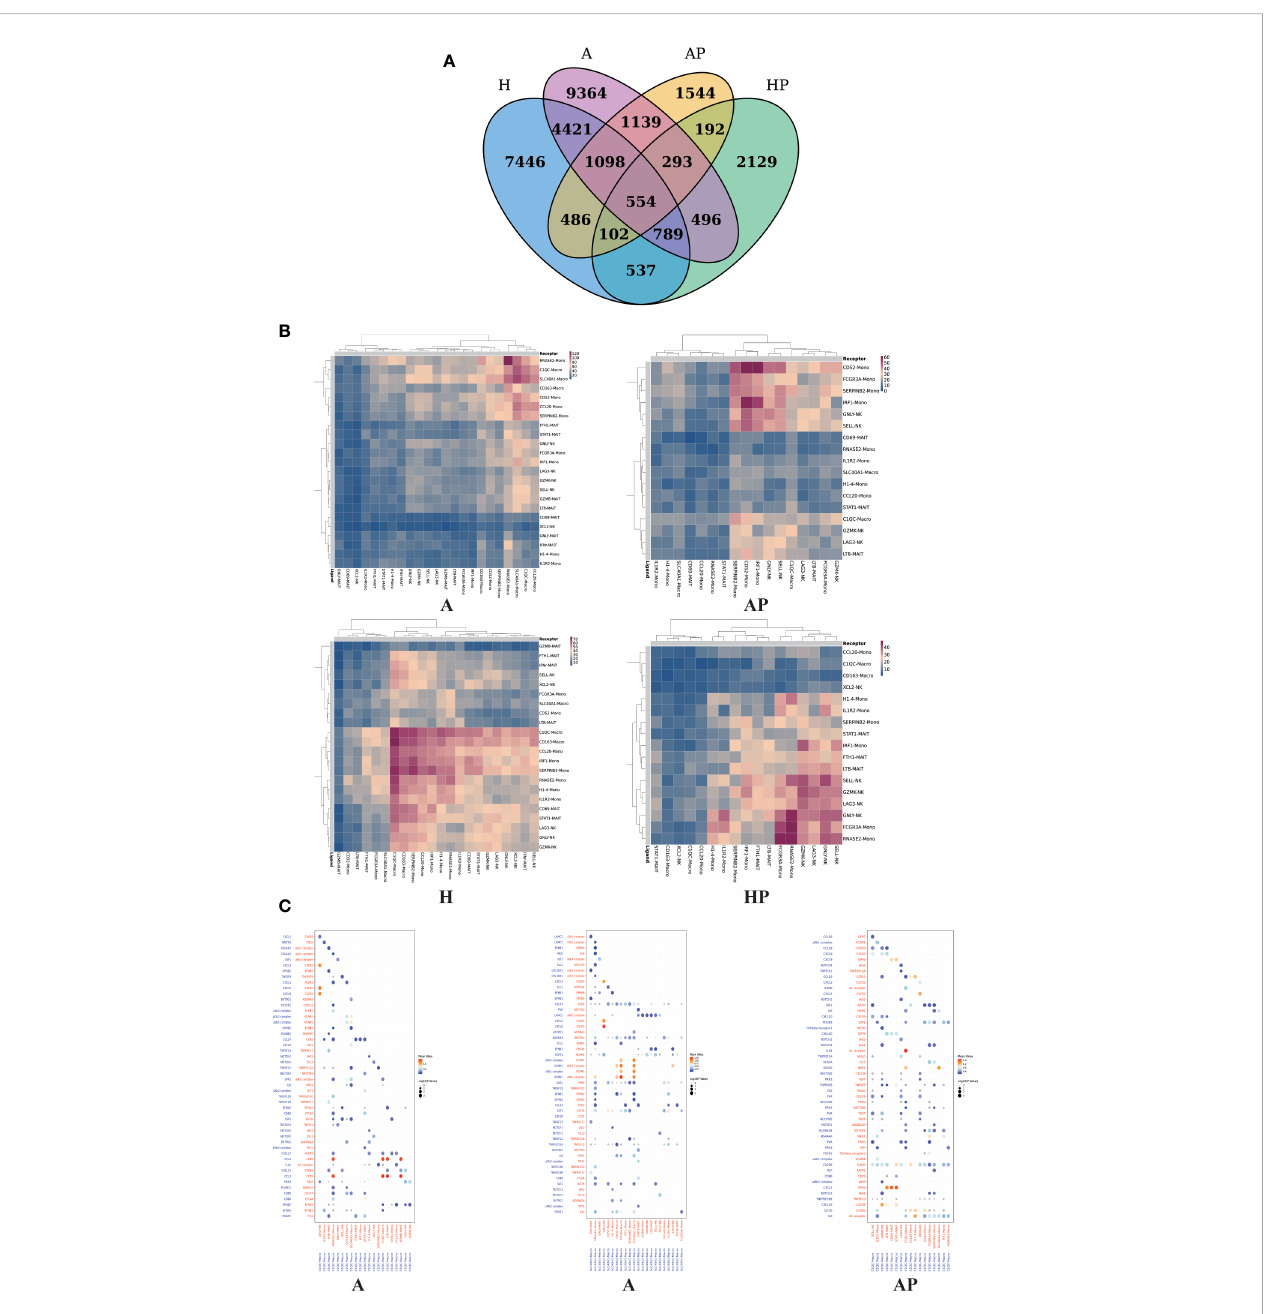
FIGURE 6 The interactions among NK cells, macrophages, and MAIT cells in the A, AP, H, and HP groups. (A) Venn diagram comparing different groups. (B) Heatmap showing the interactions among NK cells, macrophages, and MAIT cells in the A, AP, H, and HP groups. (C) Dot plot of ligand – receptor interactions among macrophages, MAIT, and NK cells in the A and AP